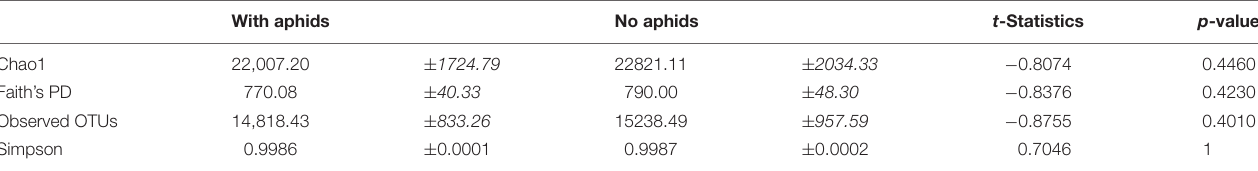
TABLE 2 | Alpha diversity metrics for aphid-infested and aphid-free 12-week-old cabbages using a non-parametric two-sample t -test using Monte Carlo permutations [Mean ( ± SD )].